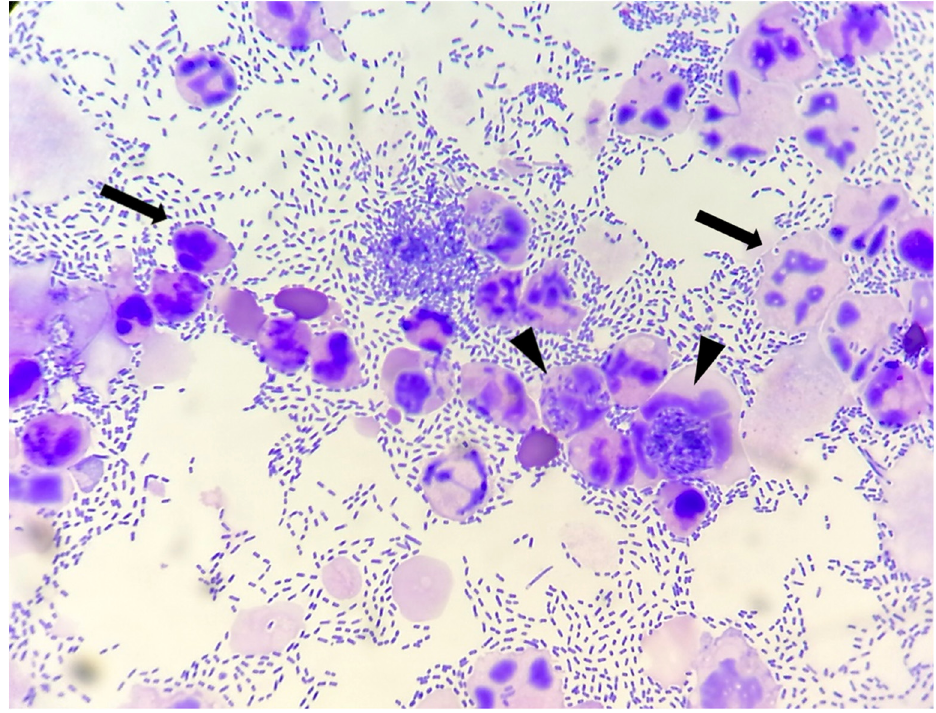
Figure 1. Canine urinary cytology performed after cytocentrifugation. Numerous rods are present, both extracellular and intracellular (arrow heads). Degenerated neutrophils are also visible (arrows). (100 ×